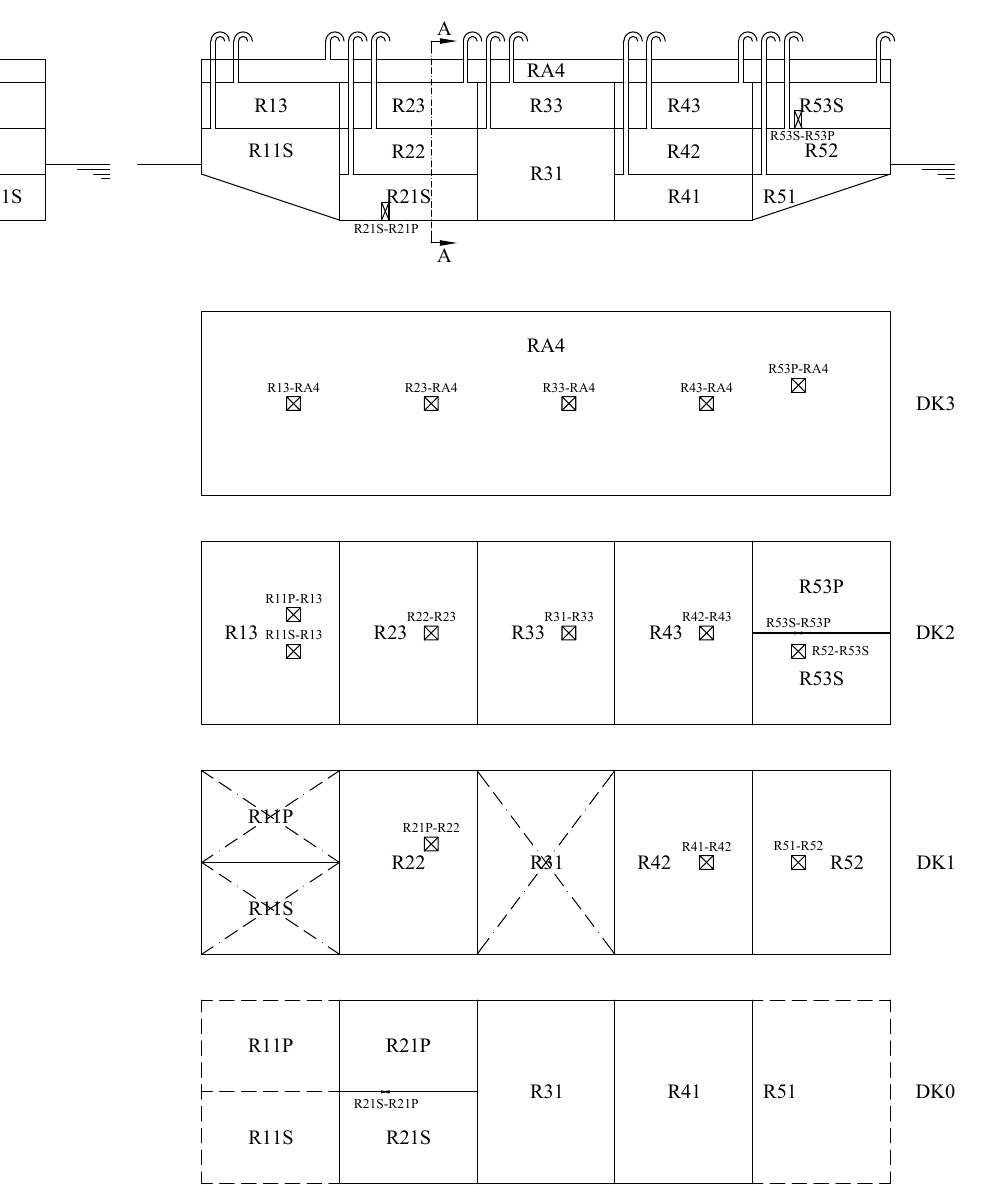
Figure 5. General arrangement of the test